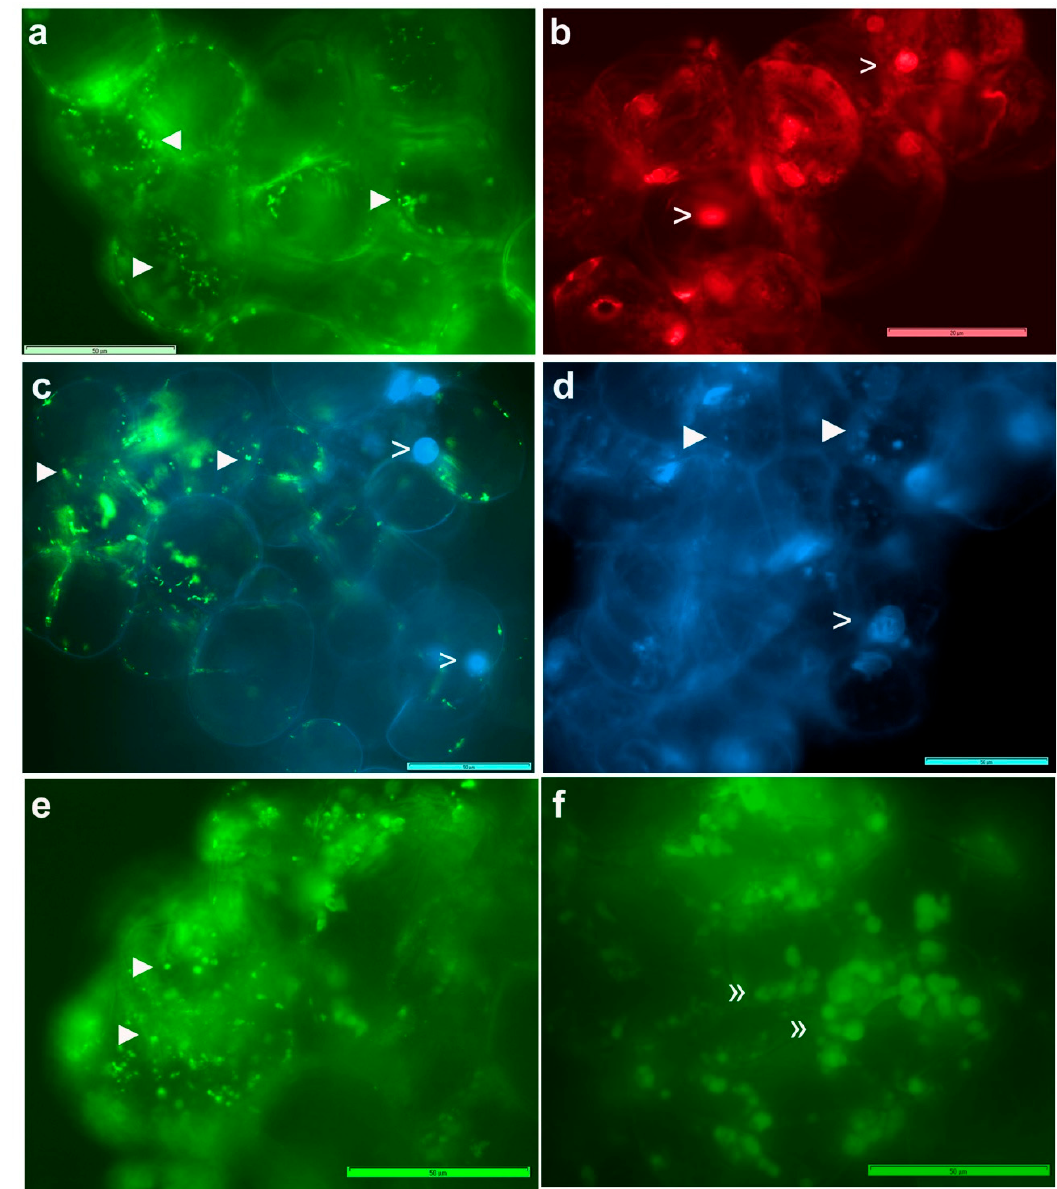
Figure 1. Grape cells stained with SYTO-9 and propidium iodide (PI) from Live/Dead bacterial staining kit, or with DAPI with or without cell permeabilization (40× objective). ( a ) Grape cells (FU01) show green fluorescing bacteria along the cell periphery and in the cytoplasm with SYTO-9, ( b ) cell nucleus stained with PI, ( c ) combined staining with SYTO-9 and DAPI showing nucleus with DAPI and fluorescing blocks of bacteria with SYTO-9, ( d ) extended staining with DAPI alone for 60 min, showing some cytoplasmic bacteria, ( e ) staining with SYTO-9 after pre-treating with Triton X-100 in water at 0.01% for 30 min showing cytoplasmic bacteria, ( f ) pre-treating with Triton X-100 0.1% in PBS for 1 h displaying cell organelles matching the expected size of mitochondria and plastids. (Symbols ► , > and » indicate bacterial cells, nuclei and organelles, respectively.) Adjustments to the entire images in brightness or color balance have been made to improve the bacterial detection extent of which is reflected in the color shade of the scale bar (bar = 50 µ